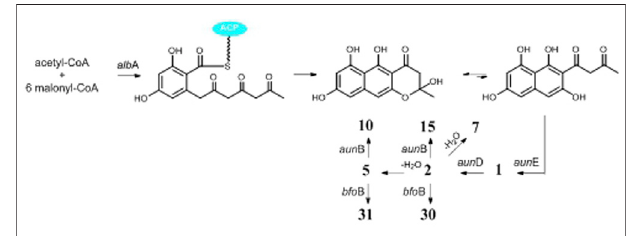
FIGURE 3 | Proposed biosynthetic pathway of γ